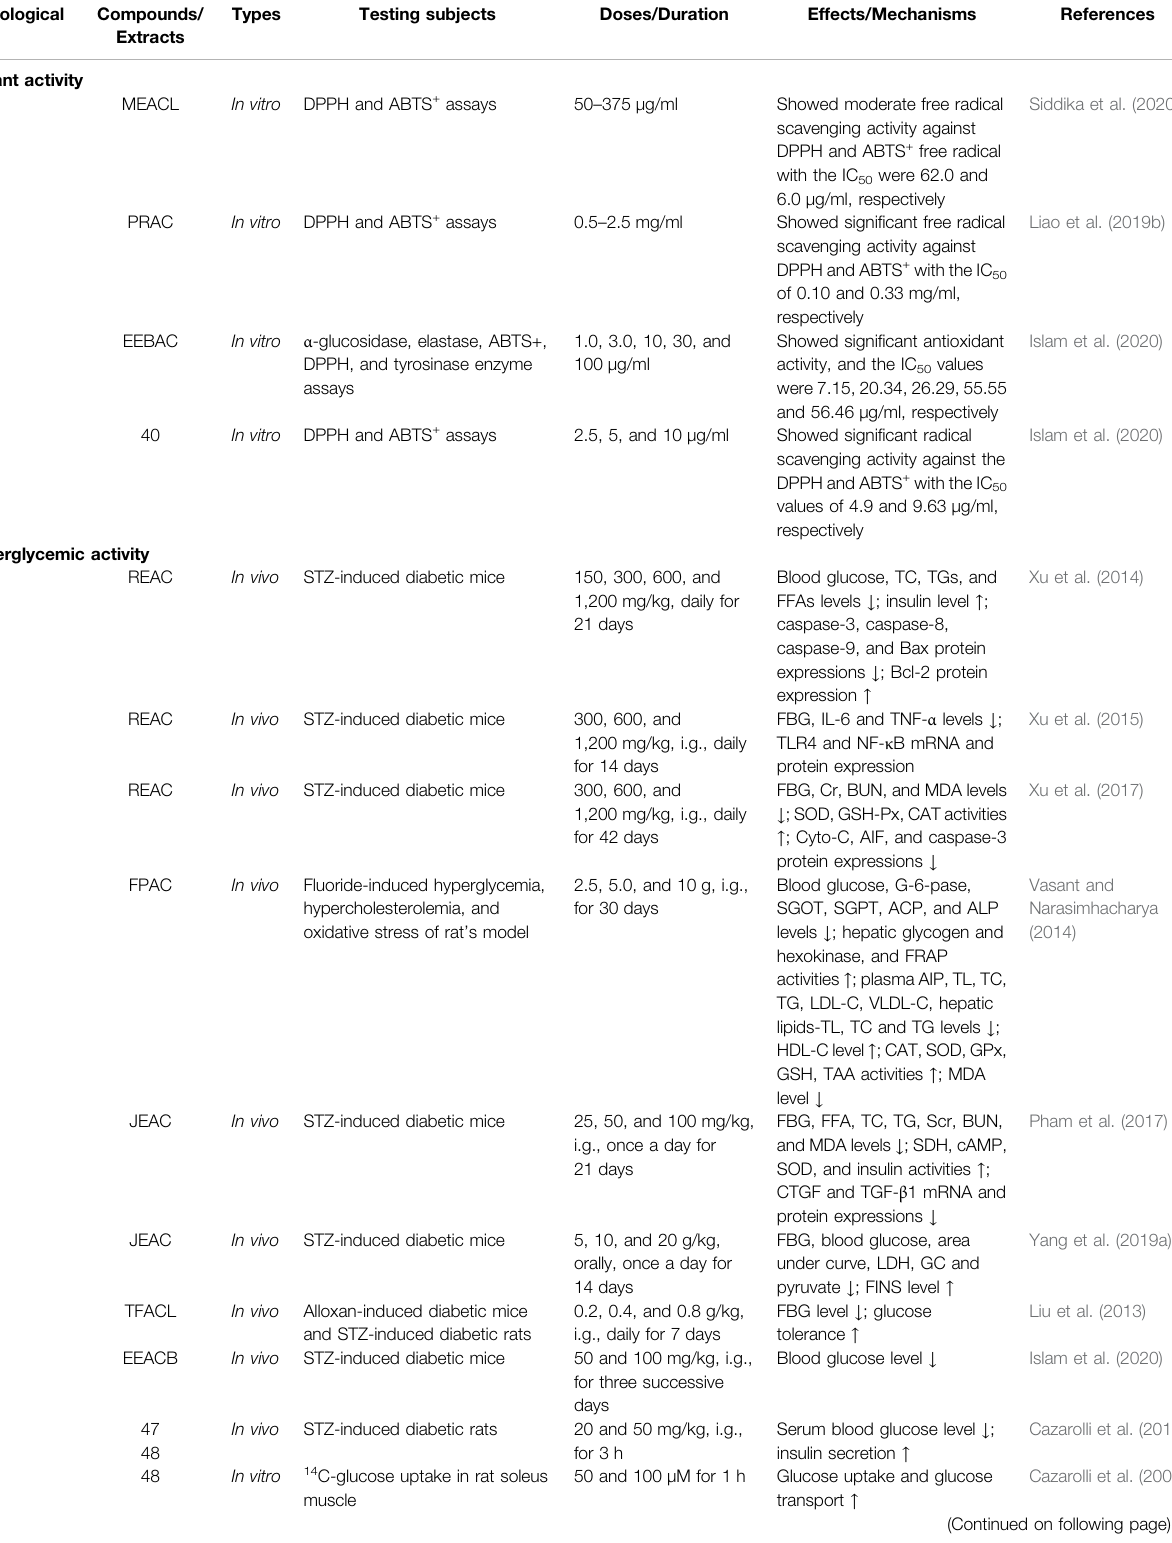
TABLE 2 | Pharmacological effects of crude extracts and bioactive compounds of A. carambola